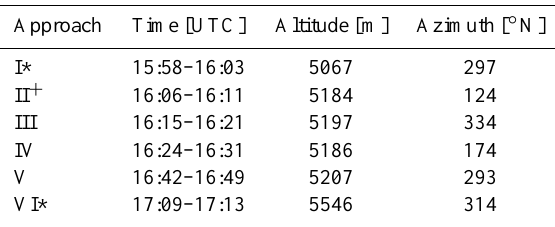
Fig. 3. Map of all six flown approaches. The start of each approach is marked by a green square, the end by a red square. The roman numbers next to the starting point correspond to the cronological order of the different approaches. Note the logarithmic colour scale of the SO 2 SCDs. Popocat´epetl is indicated with an orange dot at the lower left corner and its plume by the grey shaded area. Table 2. Mean altitude a.s.l. and azimuth direction from north for all plane approaches. Approaches marked by (*) are not used for the study e.g. due to variability in flight direction during approach or insufficient distance to the plume. Approach II ( + ) with stable flight vector inside the plume is only used for comparison between ground based and airborne measurements (Sect.